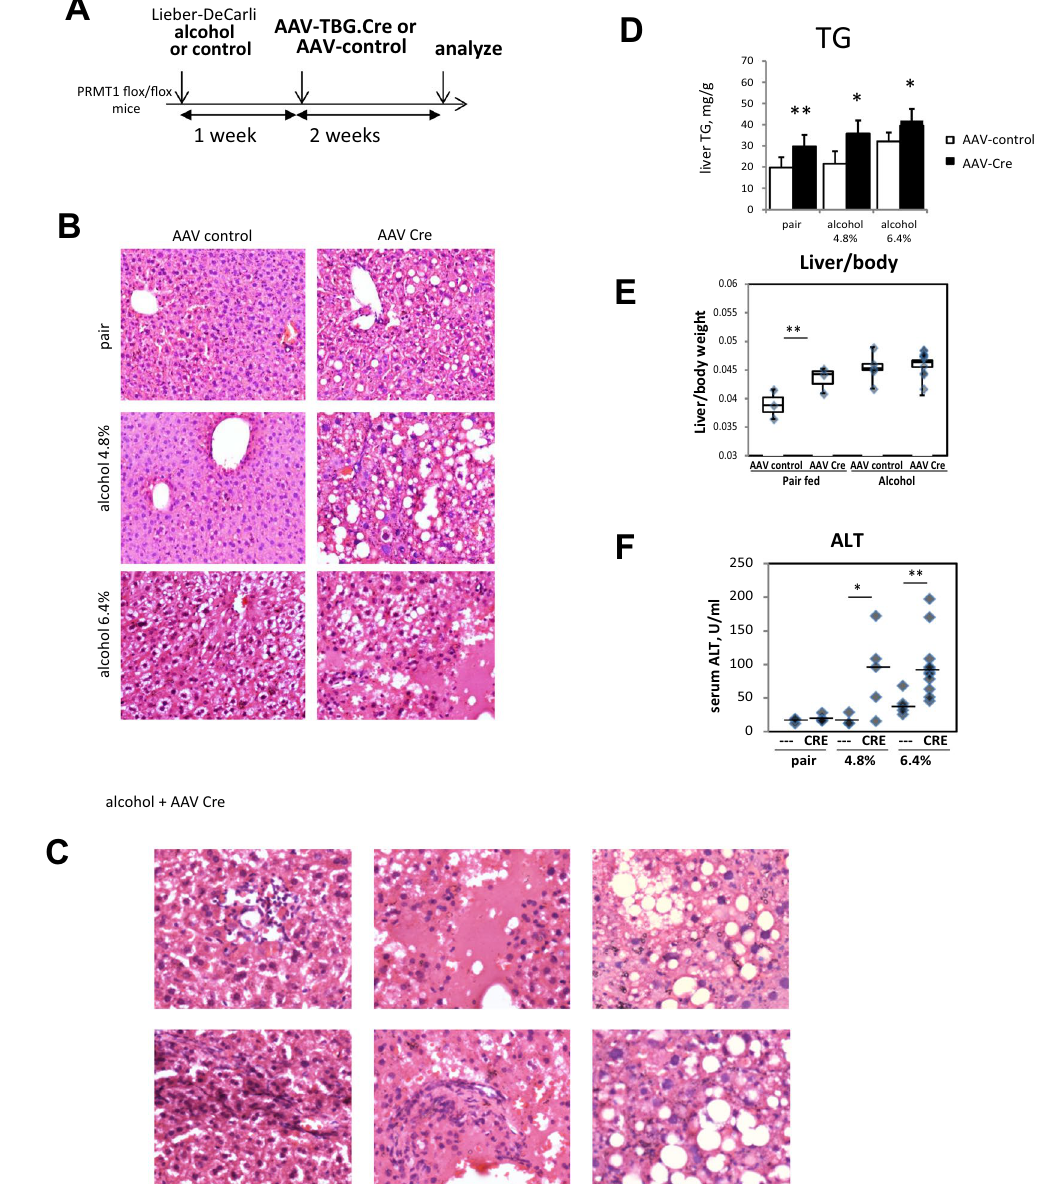
Figure 1. PRMT1 protects liver from alcohol induced liver injury. ( A ) PRMT1 flox/flox mice were for 10 days on liquid diet (control, alcohol 4.8%, or alcohol 6.4%) and received AAV-TBG.control or AAV-TBG.CRE virus (1 × 10 11 gc/mouse). Mice were left on corresponding liquid diet for 2 more weeks. N = 4–8 mice per group (B) H&E staining of liver sections from 6 groups. (C) Examples of H&E staining of liver sections from mice fed alcohol diet and received AAV-Cre showing inflammation, hepatocyte death and fibrosis. ( D) Liver triglyceride levels (TG) in livers of mice. Data are presented as mean ± SD, N = 4–8 mice per group, * p < 0.05 control vs Cre. ( E) Liver/body weight ratio and ( F ) serum ALT levels in these mice. N = 4–8 mice per group, * p < 0.05, ** p <